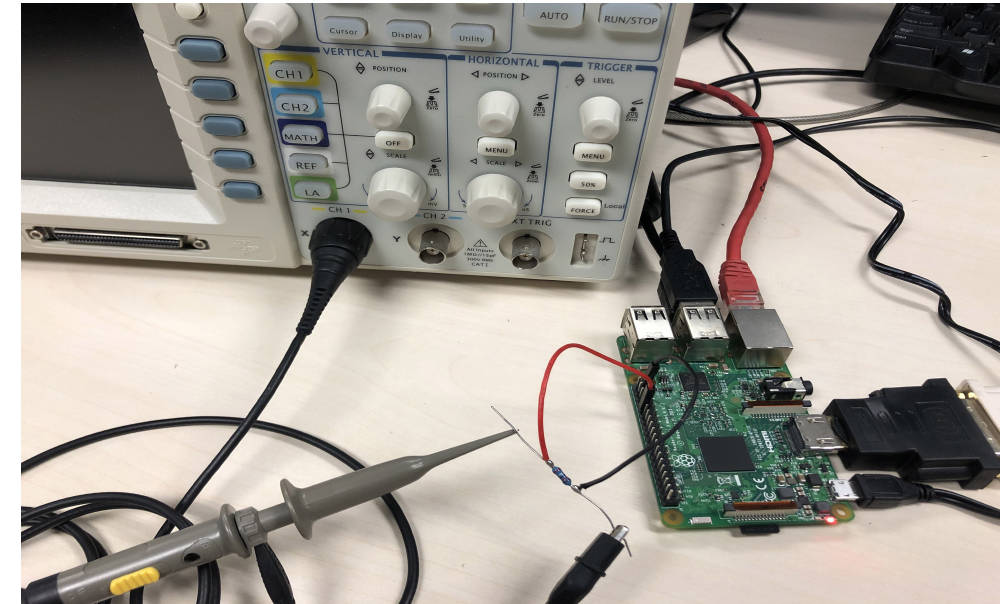
Figure 5. Raspberry Pi Ethereum experiment